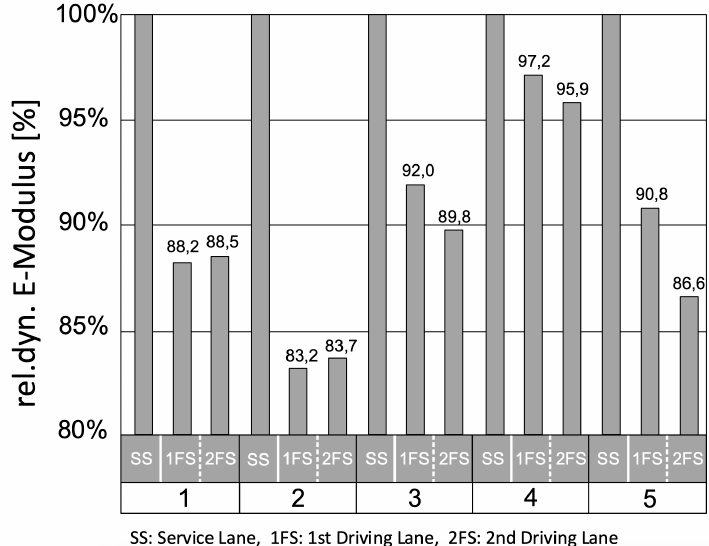
Figure 2. Relative Dynamic E-Modulus of the service lane (SS) and the driving lanes (1.FS and 2. FS)